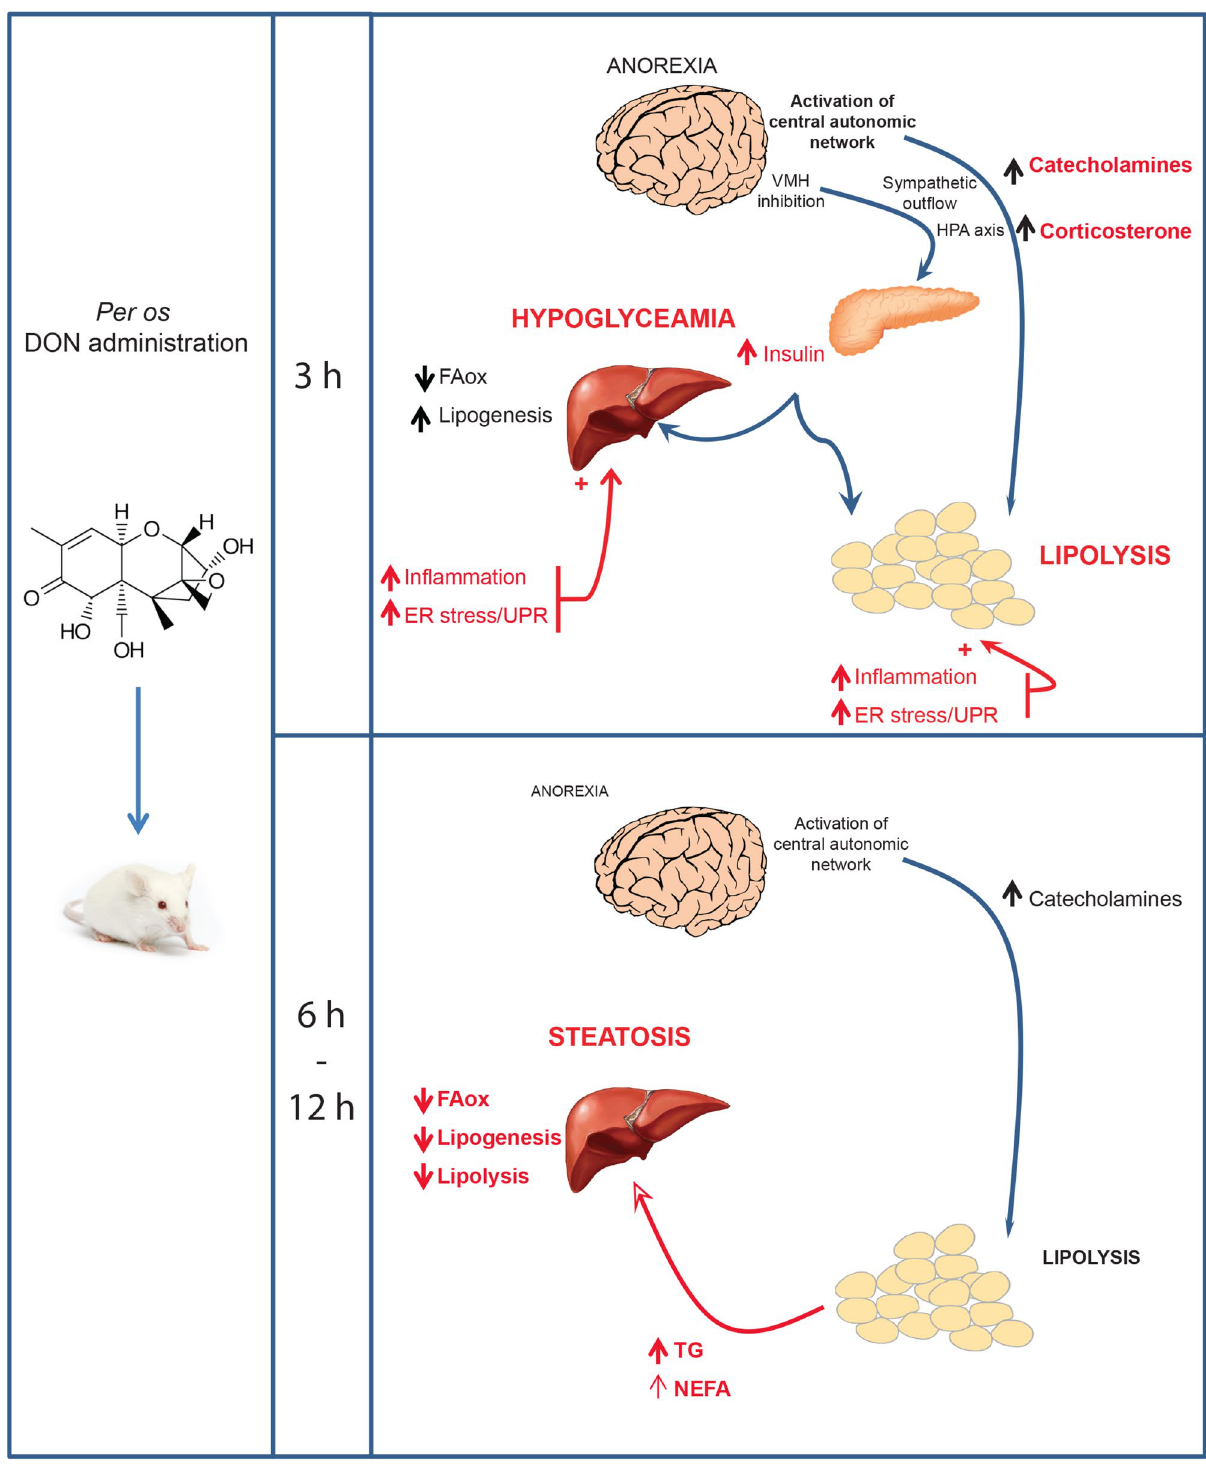
Figure 10. Schematic representation of the signaling events that might underlie the toxic effects elicited by DON intoxication on energy metabolism and liver steatosis. In an initial phase (3 h), DON induced a hormonal storm (insulin, adrenaline and corticosterone release) associated with a rise in liver lipogenesis and adipose tissue lipolysis. Moreover, inflammation and ER stress were observed within the liver and adipose tissues. A second phase intervened between 6 and 12 h where the increased blood NEFAs and TG resulting from adipose lipolysis and the drop in liver beta oxidation and lipolysis drive liver